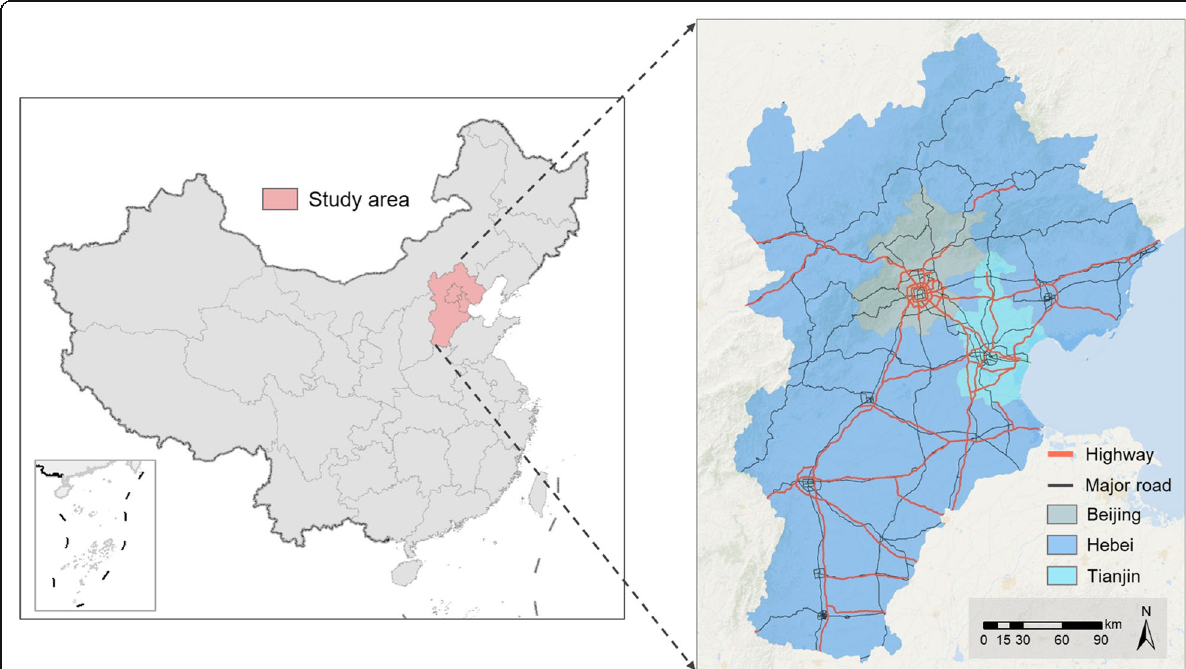
Fig. 1 The geographic location of the Beijing-Tianjin-Hebei region in China